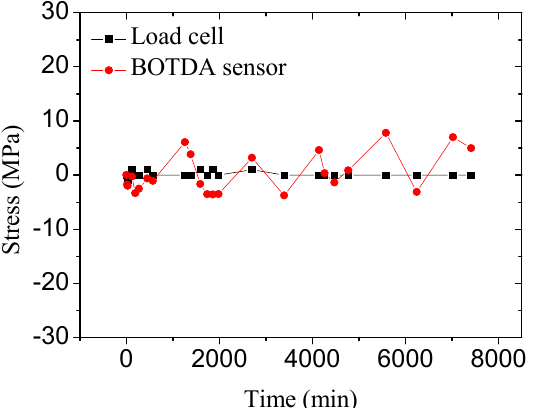
Figure 12. Prestress losses of the prestressed beam at the initial cracking stage measured by the BOTDA sensor and load cell.